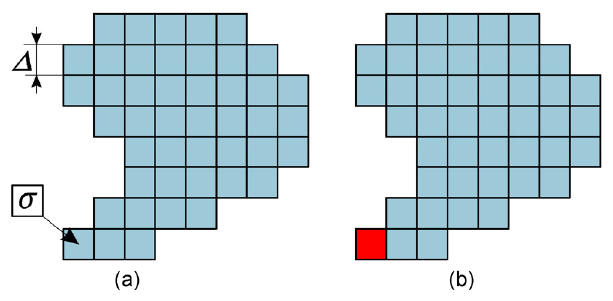
Fig. 2 In each calculation step, stress in each particular discretiza- tion element is determined. If the stress  in a given element at the boundary of the contact area exceeds the critical value (22), it is “detached” and the stress in this element is set